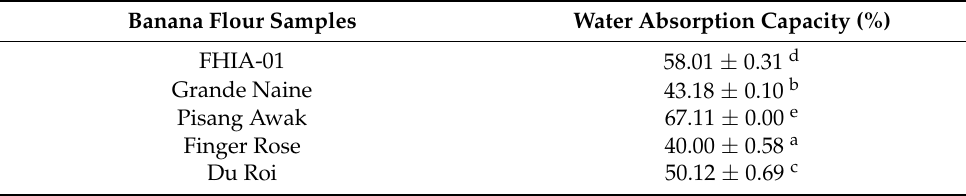
Table 3. The water absorption capacity of green banana flour